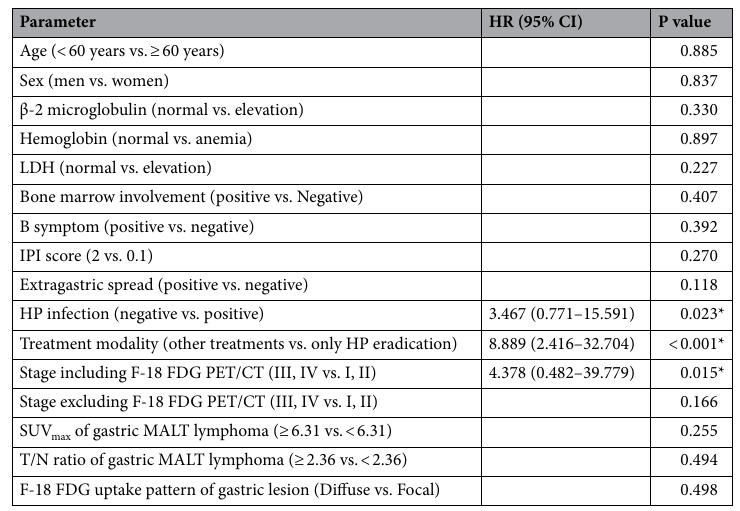
Table 2. Univariate analysis for DFS. DFS, disease free survival; HR, Hazard ratio; CI, confidence interval; LDH, lactate dehydrogenase; IPI, international prognostic index; HP, helicobacter pylori ; F-18 FDG, fluorine- 18-fluorodeoxyglucose; PET, positron emission tomography; CT, computed tomography; SUV max , maximum standardized uptake value; MALT, mucosa-associated lymphoid tissue; T/N ratio, tumor-to-normal tissue